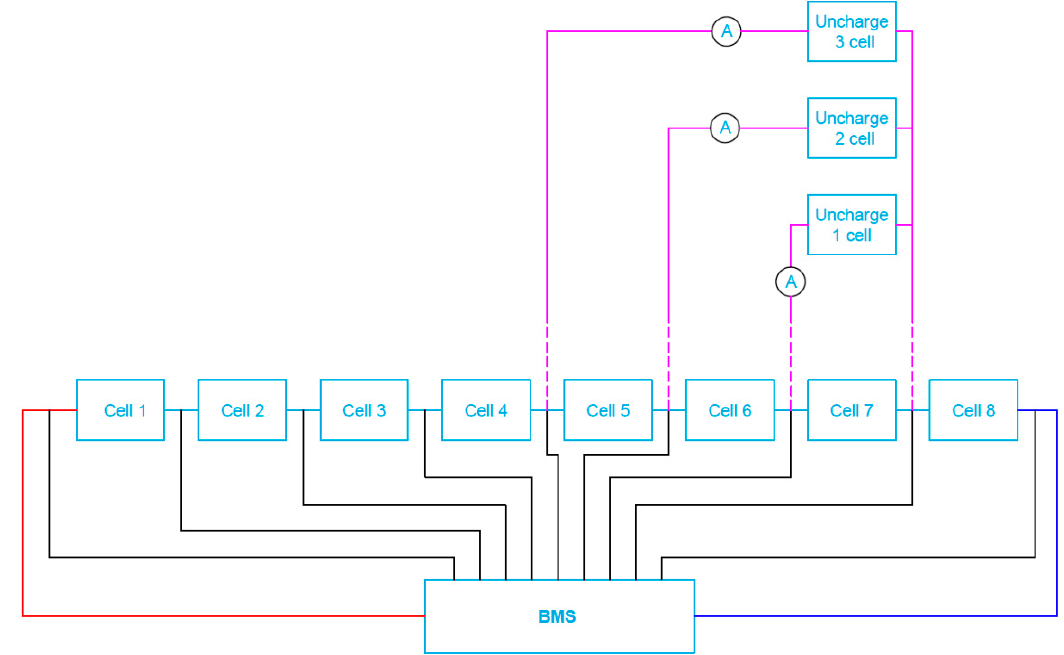
Figure 14. Block diagram of a cell test system for batteries with connected BMS when simulating one, two and/or three cell load unbalance.